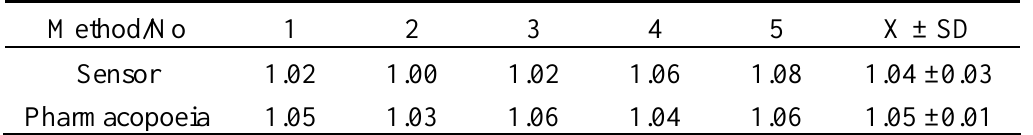
Table 4. The determination of atropine concentration for an